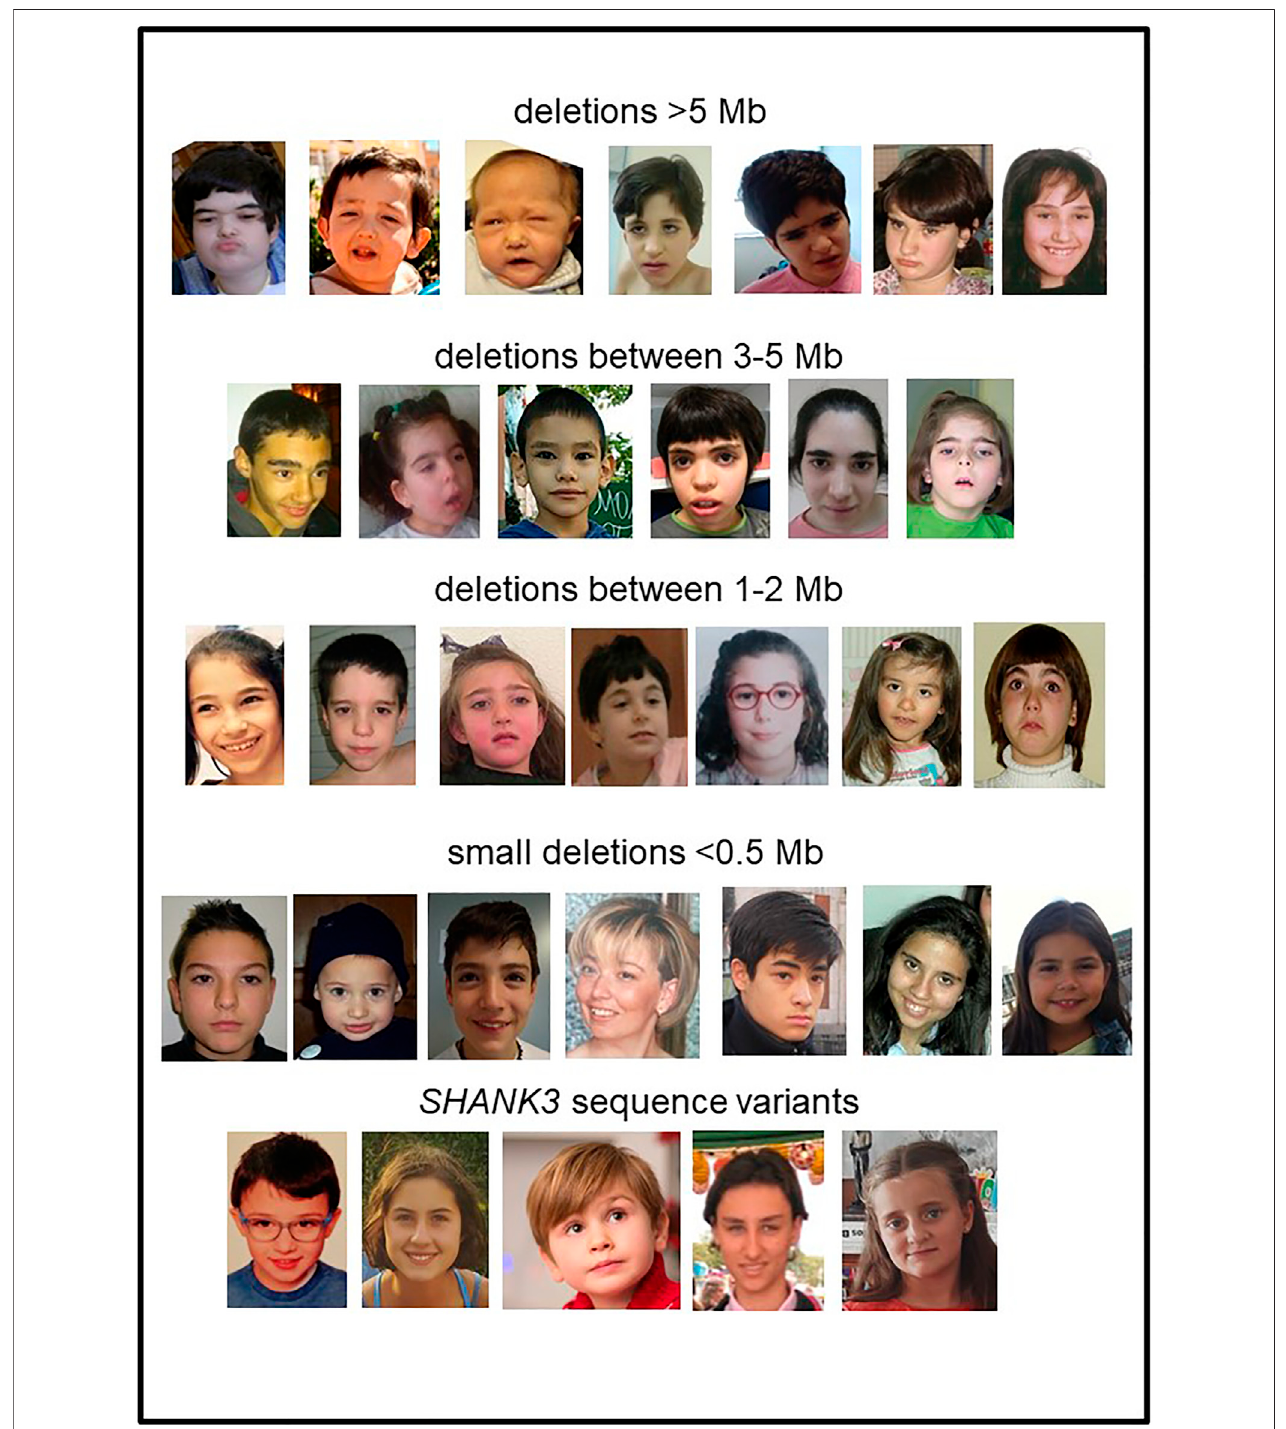
FIGURE 1 | Facial views of individuals with PMS with 22q13.3 deletions or SHANK3 sequence variants.